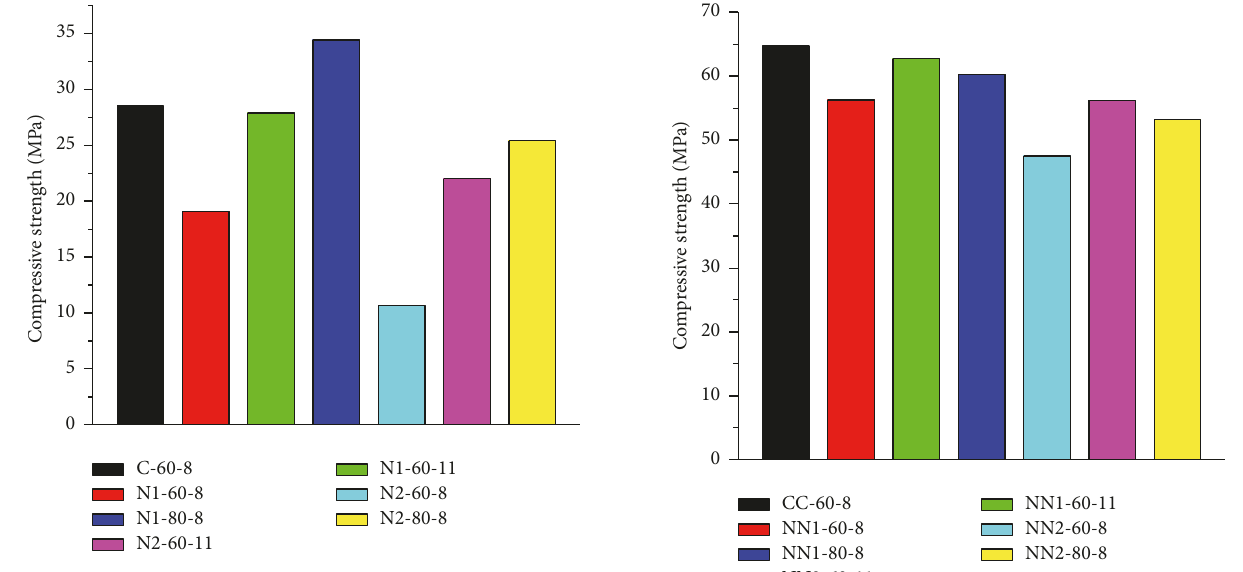
Figure 18: Demoulding strength of the steam-cured concrete with W/B of 0.4. Figure 19: Demoulding strength of the steam-cured concrete with W/B of